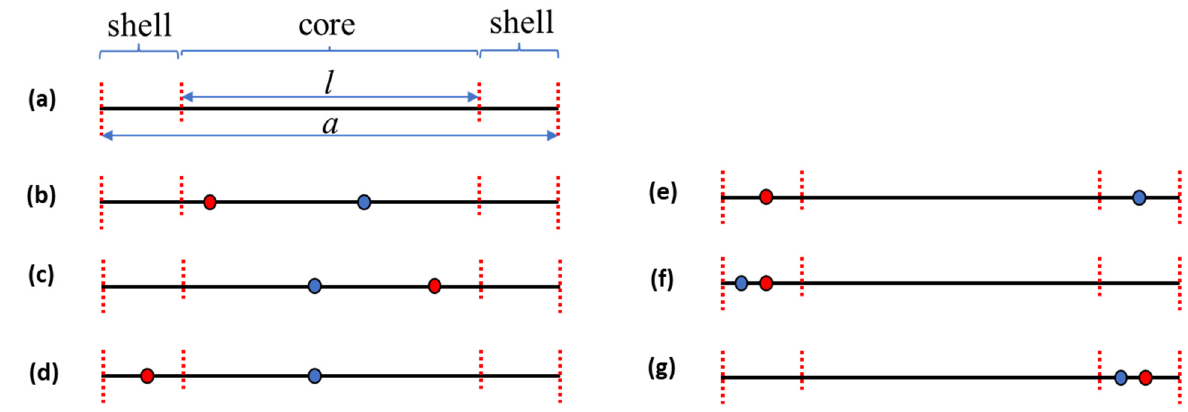
Figure 1. Diagrams showing the regions of a quantum dot (QD) ( a ). Positions of an electron and hole in a QD for case 1 ( b ), case 2 ( c ), case 3 ( d ), case 4 ( e ), case 5 ( f ), and case 6 ( g ). The filled circles in the figures represent an electron and hole.